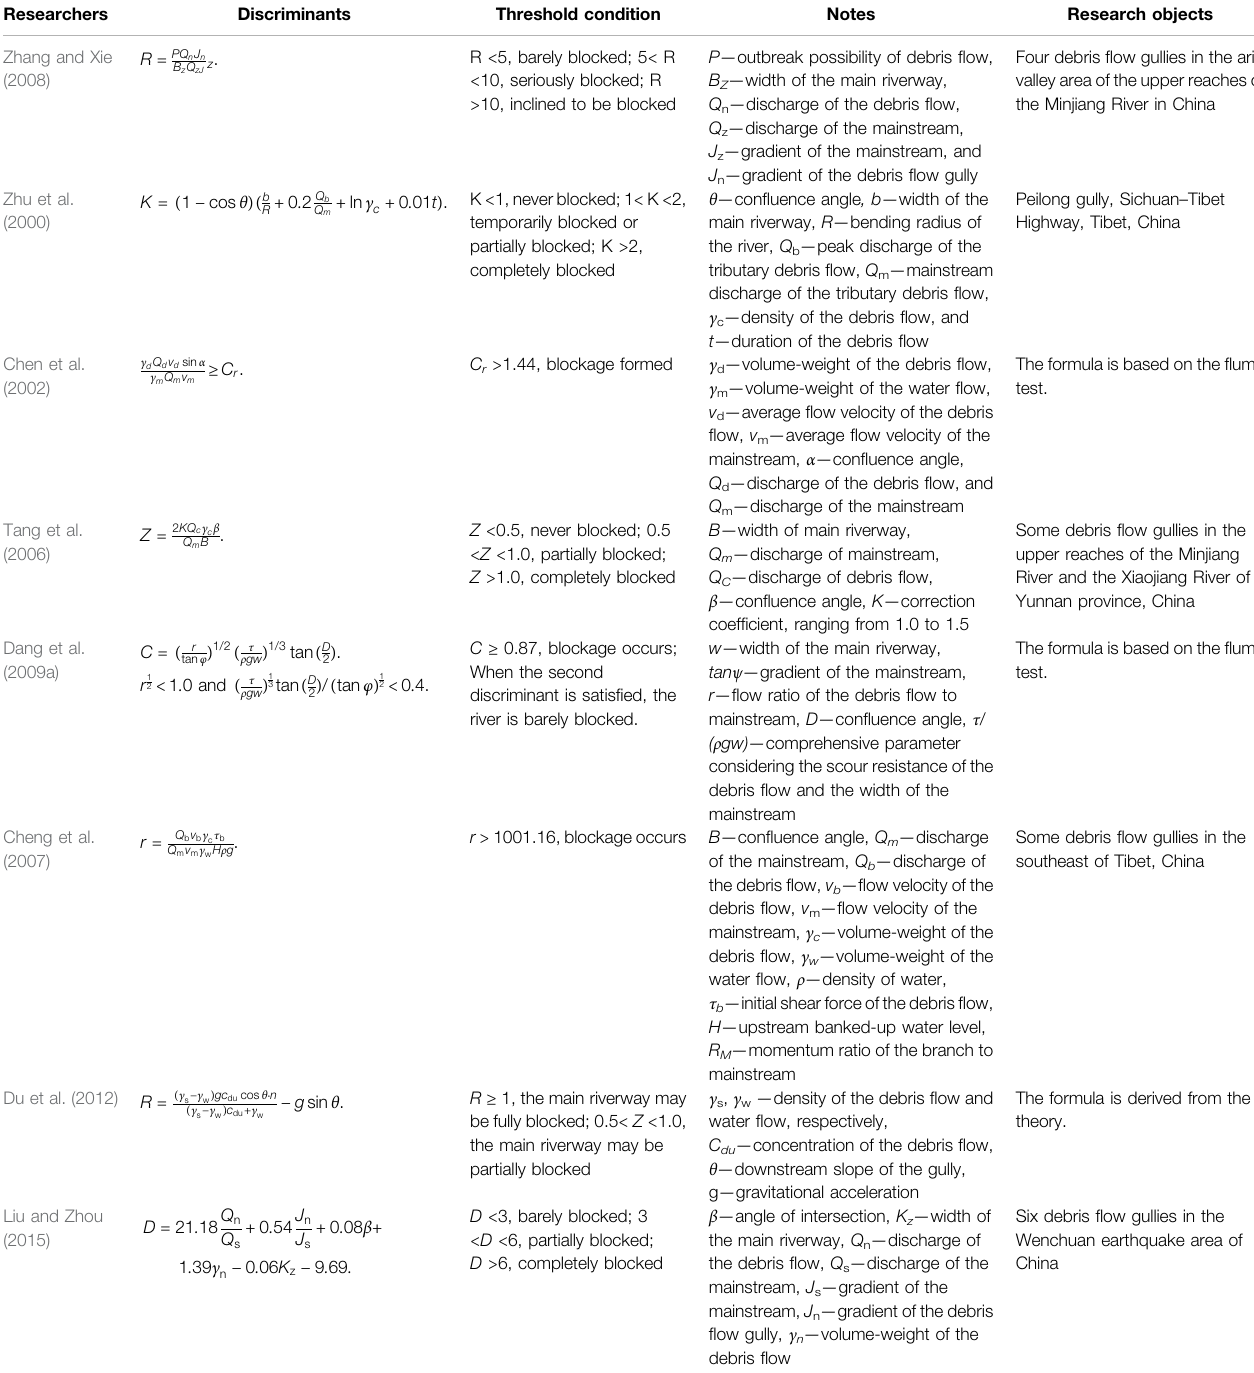
TABLE 2 | Discriminants of river blocking induced by a debris fl